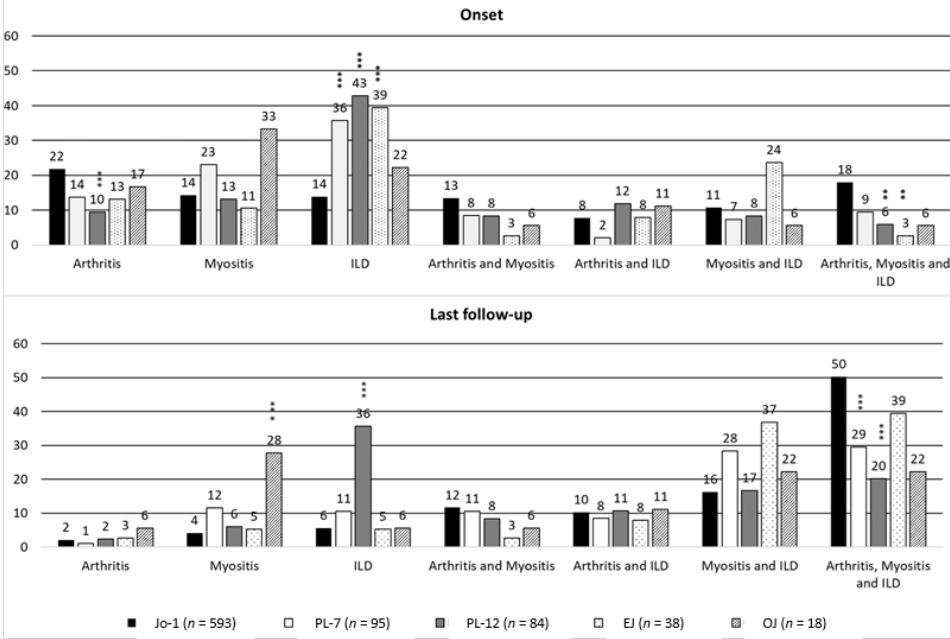
Figure 1. Triad findings cluster (in percentage) at disease onset and last follow-up. Significant di ff erences between groups were evaluated considering anti-Jo1 positive patients as the reference group. Chi-square or Fisher exact test were used as appropriate (significance threshold: p < 0.0125, reported as *** p < 0.001, ** p < 0.01). Legend: ILD, interstitial lung disease.